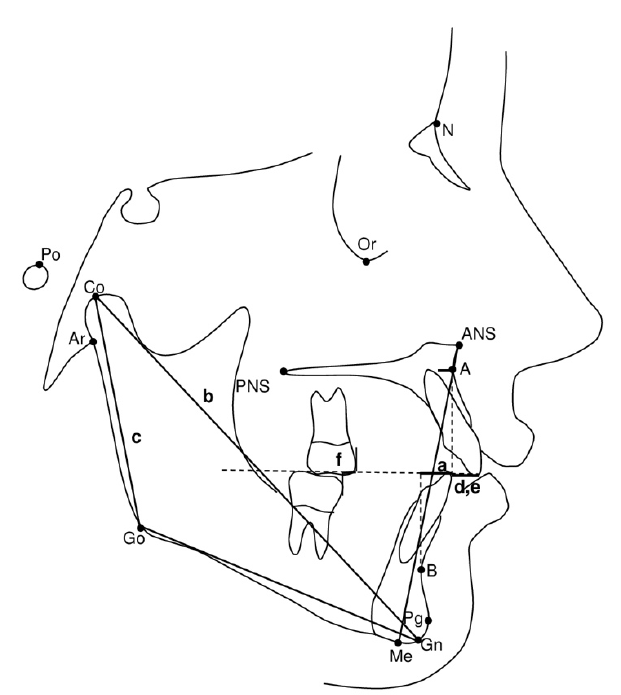
Figure 2. Linear variables considered in the study.